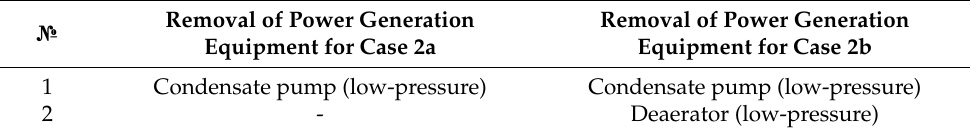
Table 7. Removal of power generation equipment for modification of TPPs with